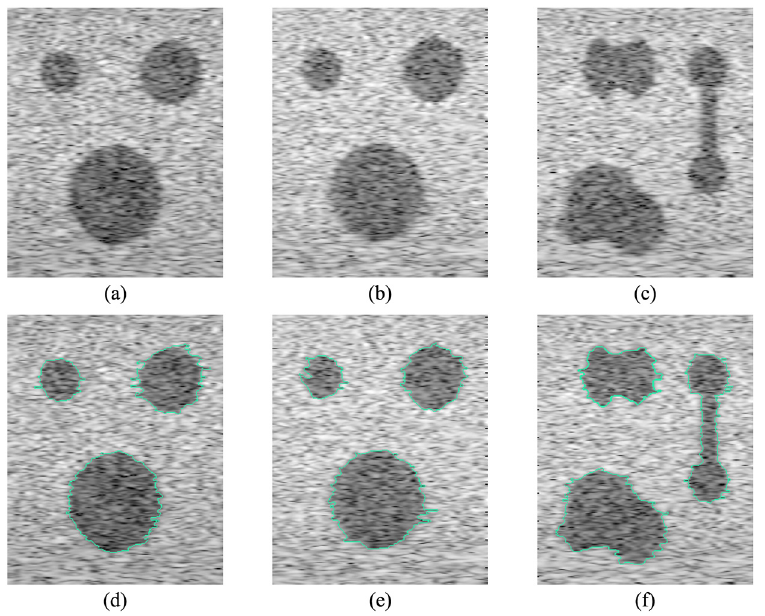
Fig 12. Results for synthetic images. (a) Amplitudes of scatters inside tumors have the same distribution. (b) Amplitudes of scatters inside tumors have different distributions. (c) Tumors whose amplitudes of scatters have different distributions have complex shapes. (d) Segmentation of (a). (e) Segmentation of (b). (f) Segmentation of